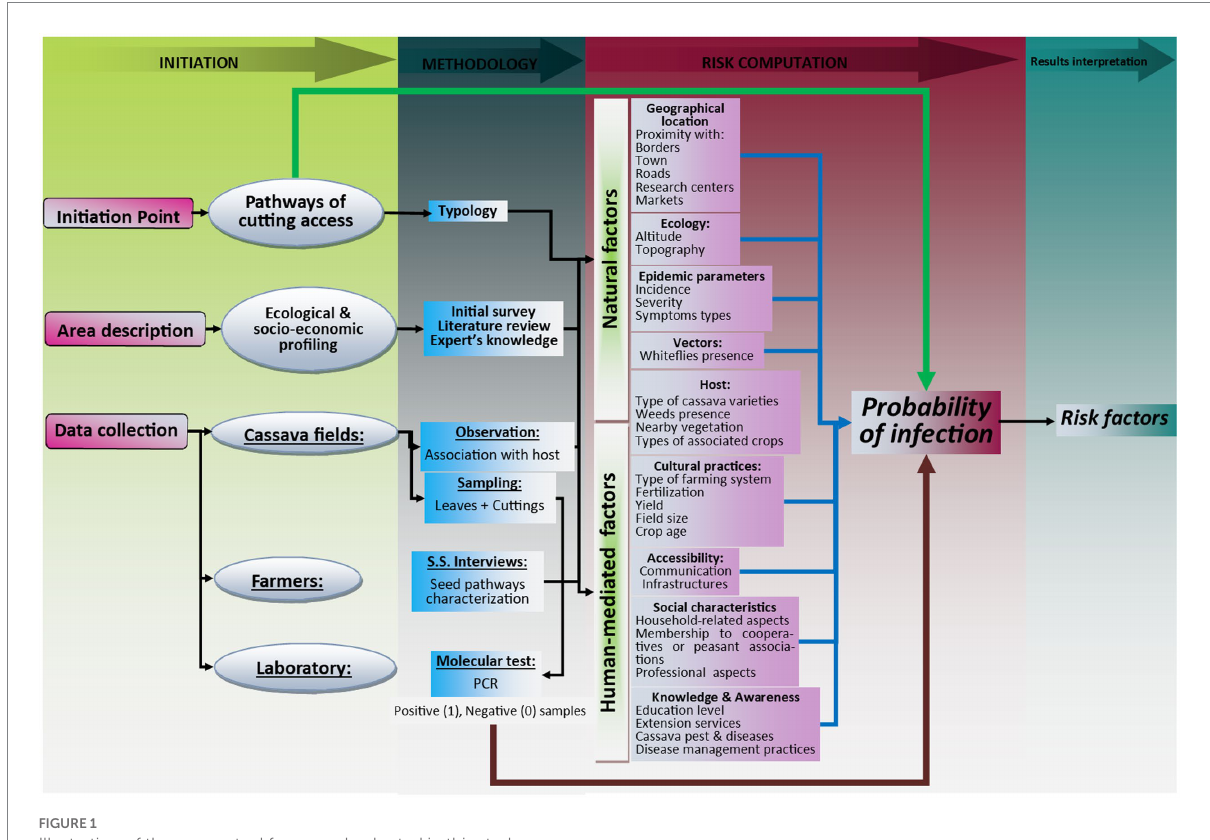
FIGURE 1 Illustration of the conceptual framework adopted in this